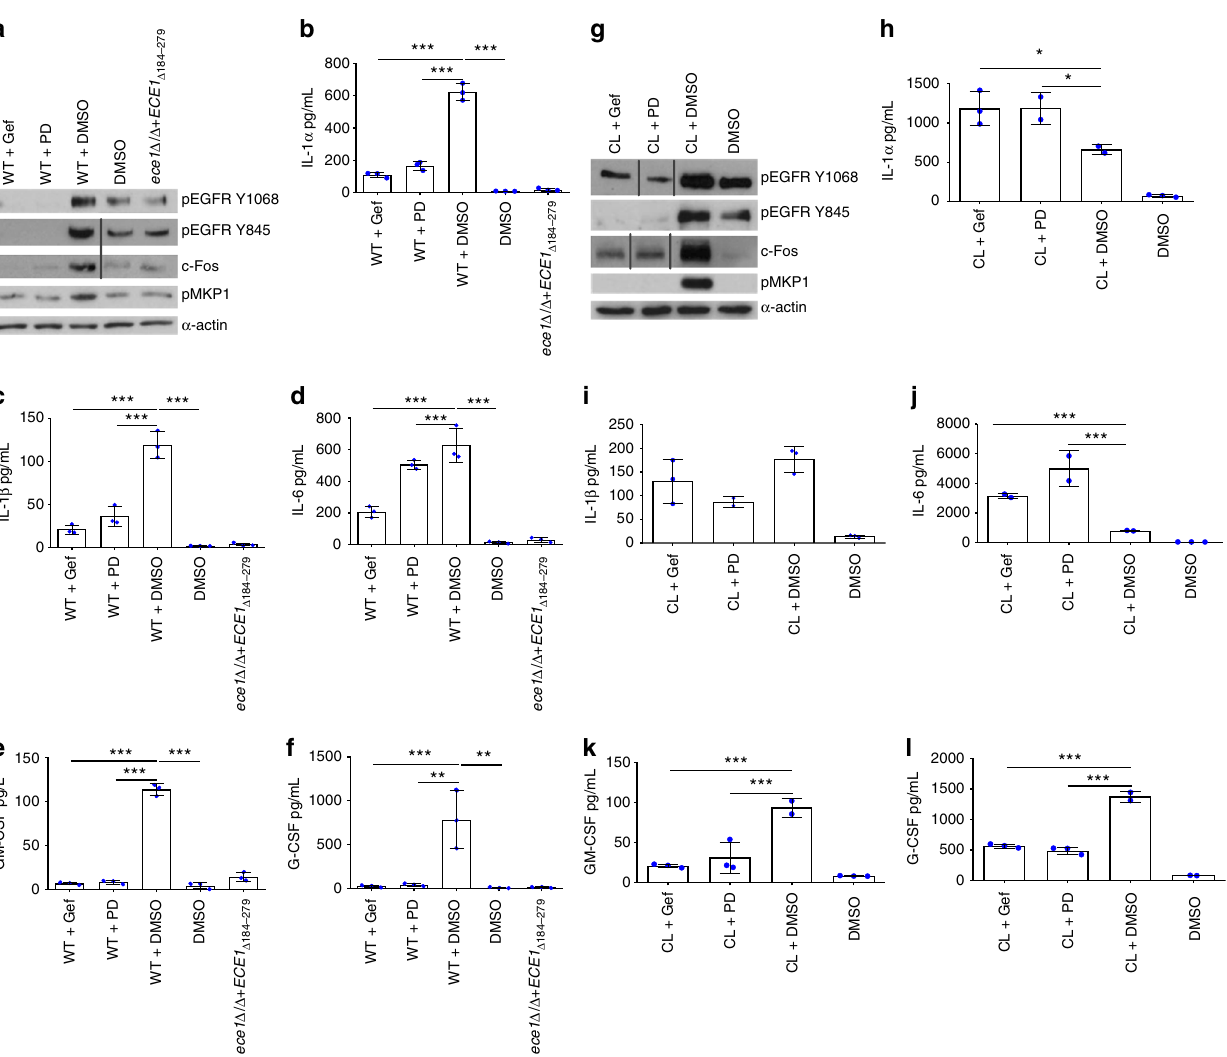
Fig. 2 Inhibition of EGFR activity suppresses C. albicans- and Candidalysin (CL)-induced protein activation and expression. Use of either Ge fi tinib or PD153035 EGFR inhibitor suppresses WT C. albicans -induced ( a – f ) and CL-induced ( g – l ) pEGFR (Y1068 and Y845), c-Fos and pMKP1 ( a , g ), as well as secretion of GM-CSF ( e , k ) and G-CSF ( f , l ). Both EGFR inhibitors suppressed C. albicans -induced IL-1 α , IL-1 β , IL-6 ( b – d ) but not CL-induced IL-1 α , IL-1 β , IL-6 ( h – j ). The CL-de fi cient ece1 Δ / Δ + ECE1 Δ 184 – 279 strain poorly induced all proteins investigated. The data are representative images ( a , g ) or combined averages of three independent experiments ( b – f , h – l ). Protein lysates taken at 2 h post infection for western blot analysis, cytokines assessed at 24 h post infection via luminex. Solid vertical lines indicate omitted, extraneous portions of blot images. Unmatched, one-way ANOVA with Bonferroni multiple comparison ’ s test was used to assess statistical signi fi cance. Error bars represent SD, * p < 0.05, ** p < 0.01, *** p <